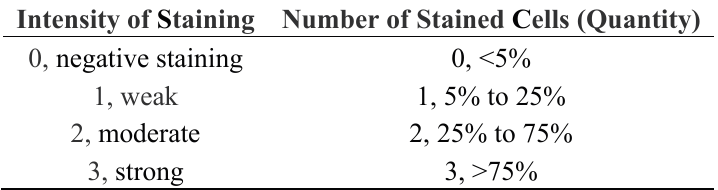
Table 1. The immunoreactivity score (IRS) calculation method. The final score was calculated by multiplying the staining intensity value by the percentage of